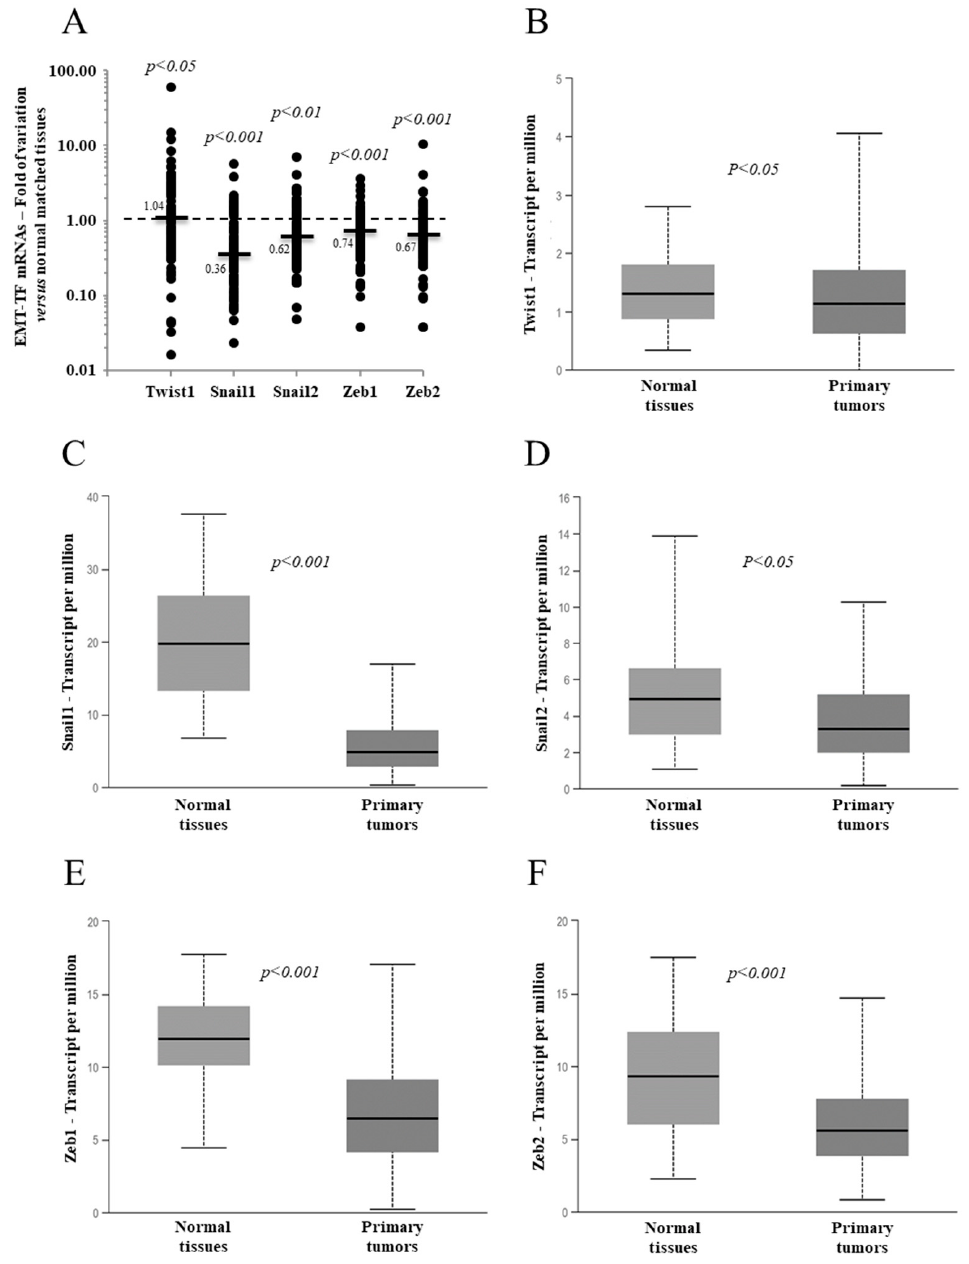
Figure 1. Expression level of the EMT transcription factors (EMT-TFs) in 95 papillary thyroid cancer (PTC) tissues compared with the normal matched tissues from our case study ( A ) or from The Cancer Genome Atlas network ( B – F ) case study consisting of 59 normal tissues and 505 PTC tissues. ( A ) The small bars represent the median with the values indicated. The dotted line represents the expression level for the normal matched tissues. ( B – F ) The data are presented as a box plot reporting the median value (small bar) and the first (lower box limit) and third (upper box limit) quartiles and range of the values observed for each